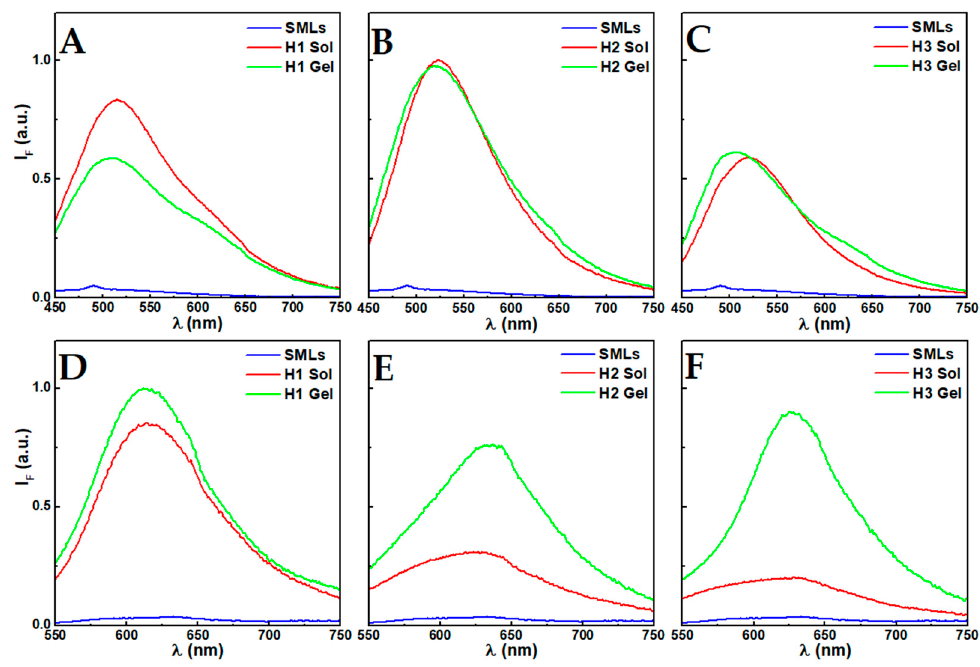
Figure 5. ( A – C ) Fluorescence emission spectra of curcumin and Nile Red in solid magnetoliposomes of DPPC ( λ exc = 420 nm, [curcumin] = 2 × 10 − 6 M, [Nile Red] = 2 × 10 − 6 M) in solution of SMLs (SMLs), in a pre-gelation solution (pH ≈ 12, Sol) and hydrogel state (Gel) of the compounds H1, H2 and H3. ( D – F ) Fluorescence emission spectra of Nile Red ( λ exc = 520 nm, [Nile Red] = 2 × 10 − 6 M) in solid magnetoliposomes in an aqueous solution (SMLs), in a pre-gelation solution (pH ≈ 12, Sol) and hydrogel state (Gel) of the compounds H1, H2 and H3.